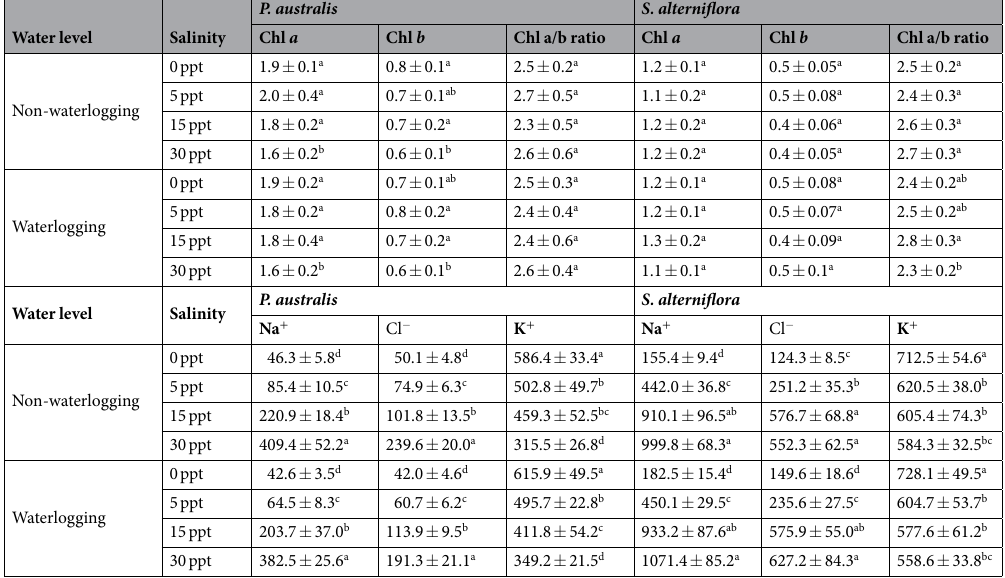
Table 3. Concentrations of chlorophyll (mg g − 1 FW) and cations and anion ( μ mol g − 1 DW) in the leaves of P. australis and S. alterniflora under waterlogging and salinity treatments. FW and DW indicate fresh weight and dry weight, respectively. The measurements were conducted in September. Different letters indicate significant differences ( P < 0.05) among salinity treatments for each